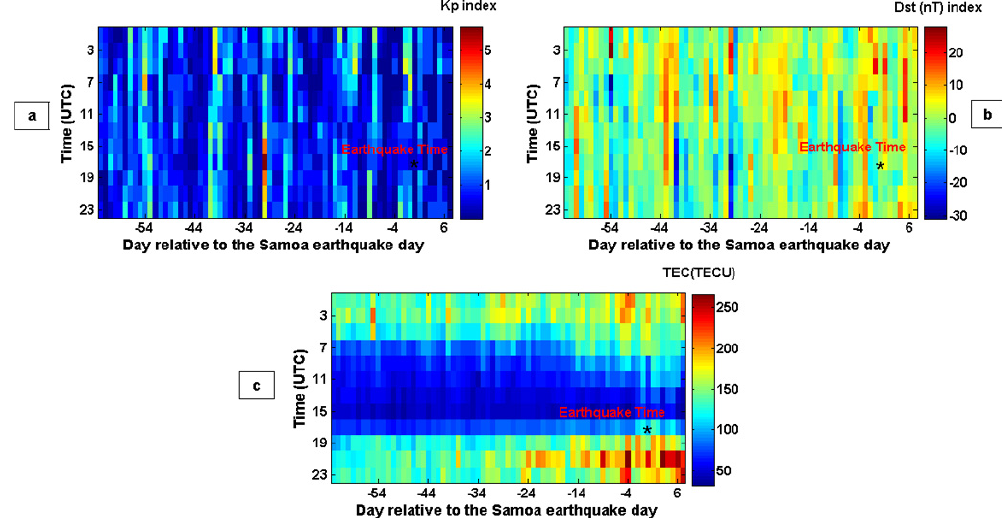
Fig. 9. Data of the Samoa earthquake showing variations of (a) Kp geomagnetic index, (b) Dst geomagnetic index and (c) TEC.